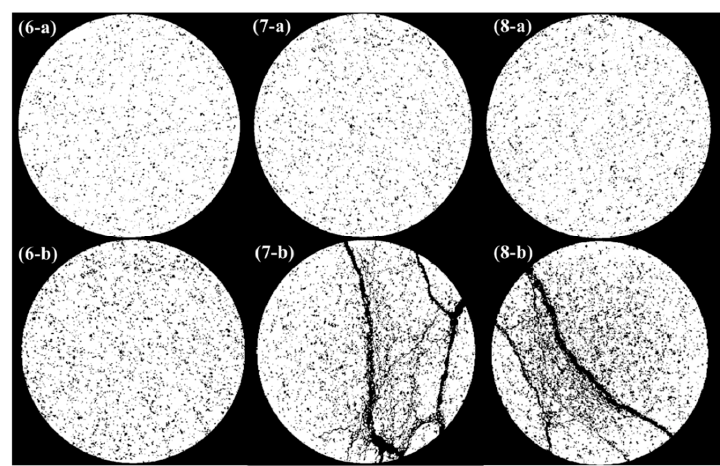
Figure 11. CT scan slice image after being segmented (6–8 represent the specimen ID, while a and b indicate the initial state and damage state respectively).